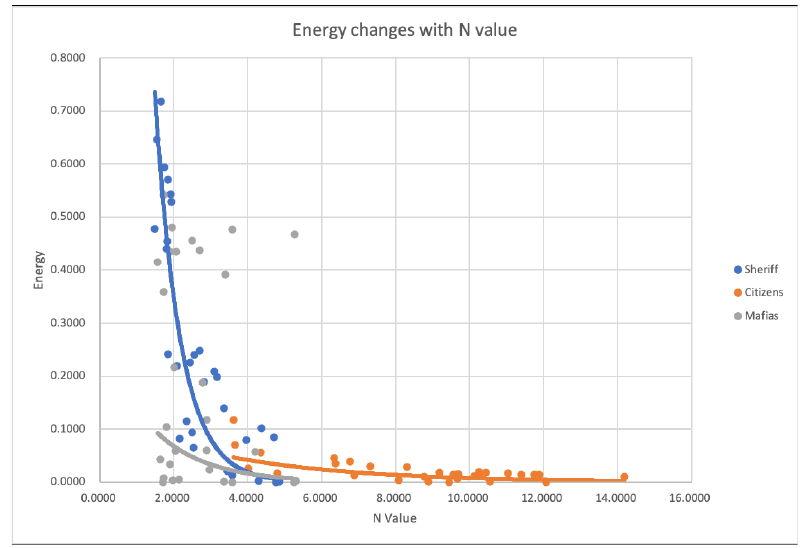
Figure 2. Energy changes of each